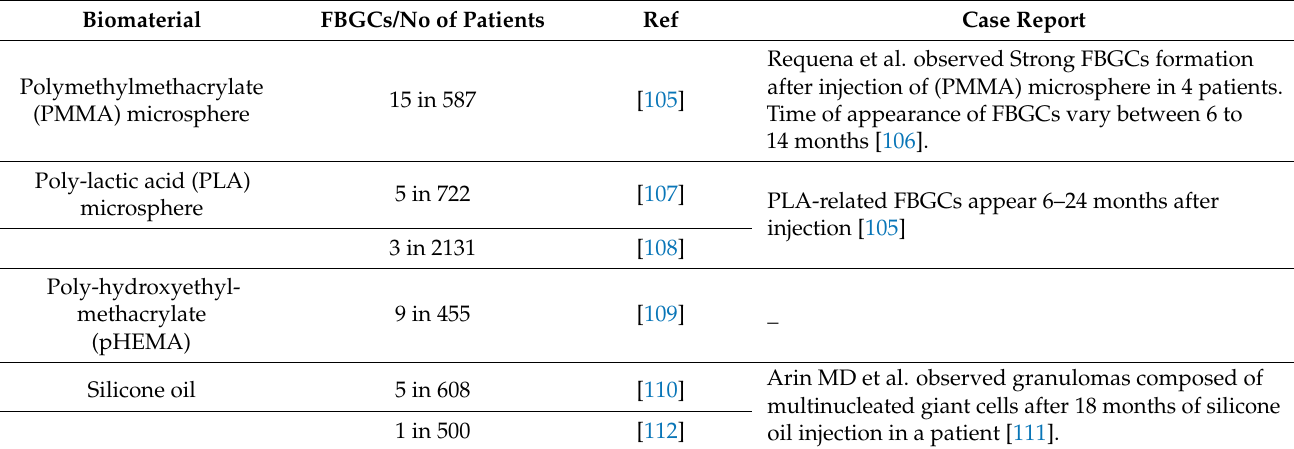
Table 1. Rate of FBGCs formation after biomaterials implantation along with their case